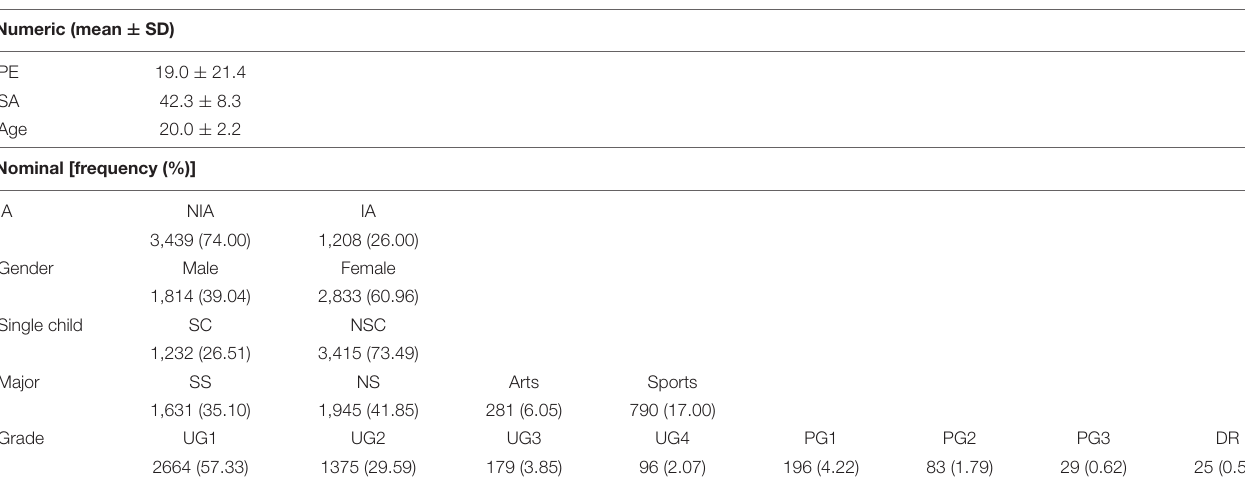
TABLE 1 | Descriptive data of the predictor and dependent